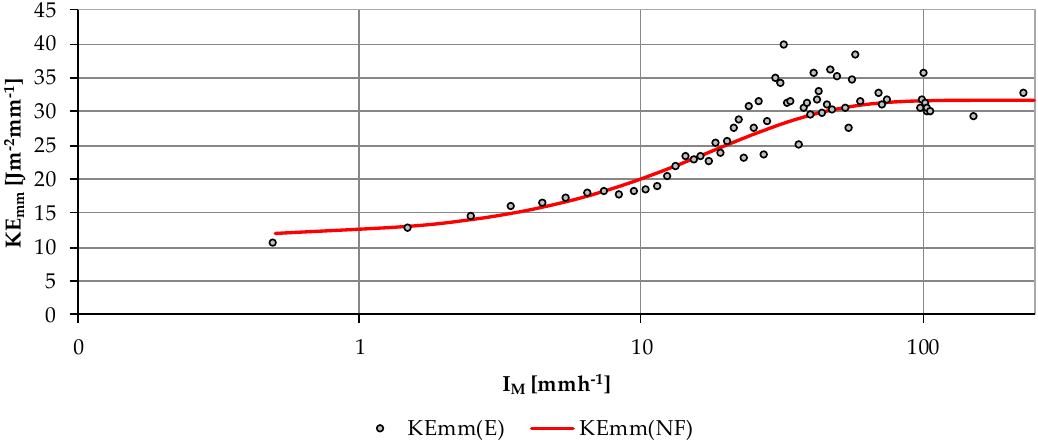
Figure 14. Mean values KE time(NF) vs . I M (grey dots) and the relationship calculated for the present study (red line).